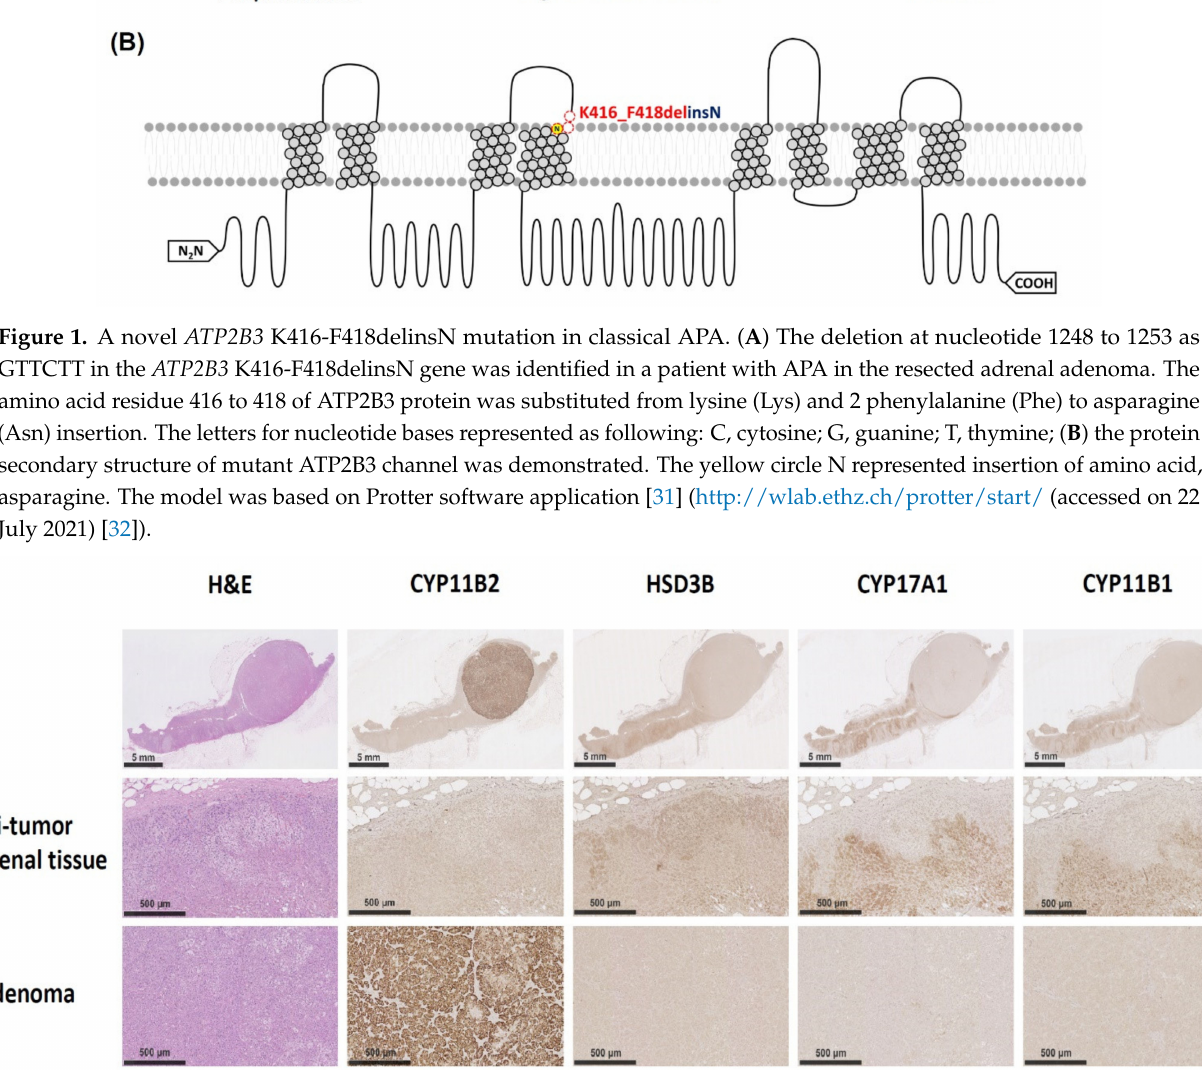
Figure 2. The immunohistochemistry staining in unilateral PA patients with the ATP2B3 K416-F418delinsN mutations. The CYP11B2 and other steroidogenesis related enzyme IHC staining was conducted. The CYP11B2 immunoactivity was stained intensely within the adenoma, but did not stain in the adjacent adrenal gland tissue. Of note, HSD3B, CYP17A1 and CYP11B1 did not observed with adenoma but scattered in the residual adrenal gland tissue. Scale bar represented 500 µ